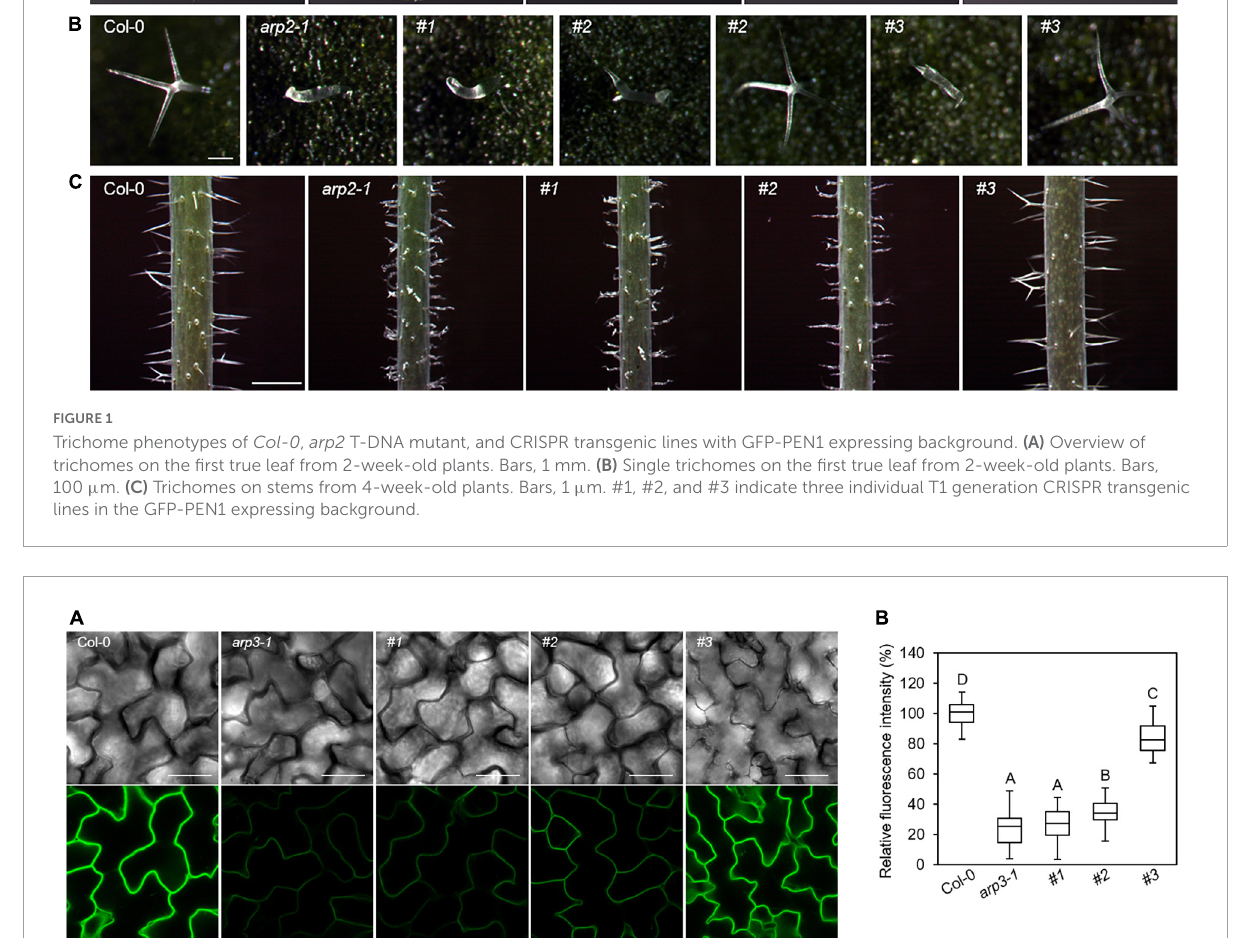
detailed sequence information covering the three gRNA